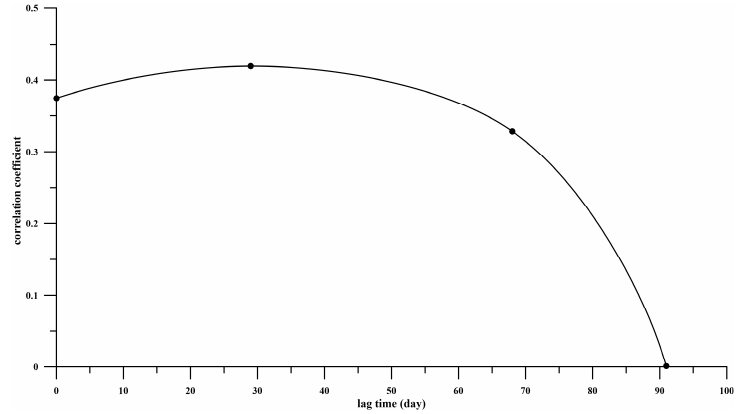
Figure 7. The correlation under different lag-time for #1 and #1.